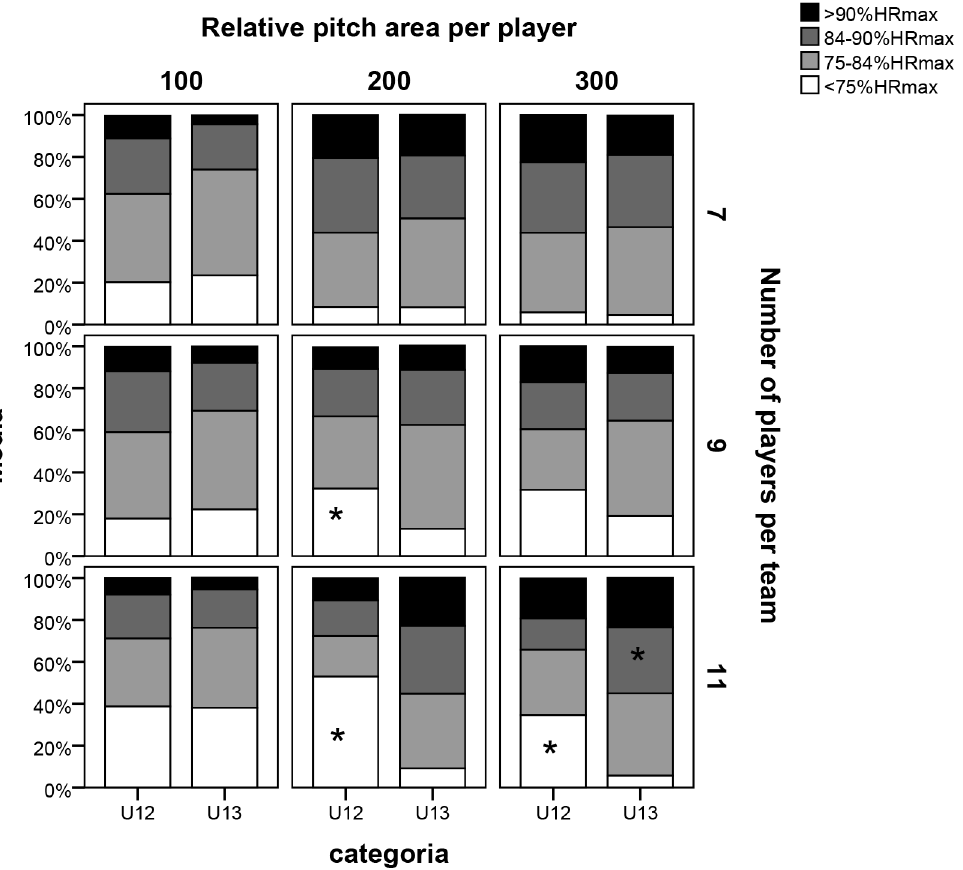
Fig 2. Percentage time spent in each heart rate intensity zone for each of the nine large-sided games. Note: 100, 200, and 300 refer to the relative pitch area (in m 2 ) per player, while 7, 9, and 11 correspond to the number of players per team. * Significant difference between categories p <